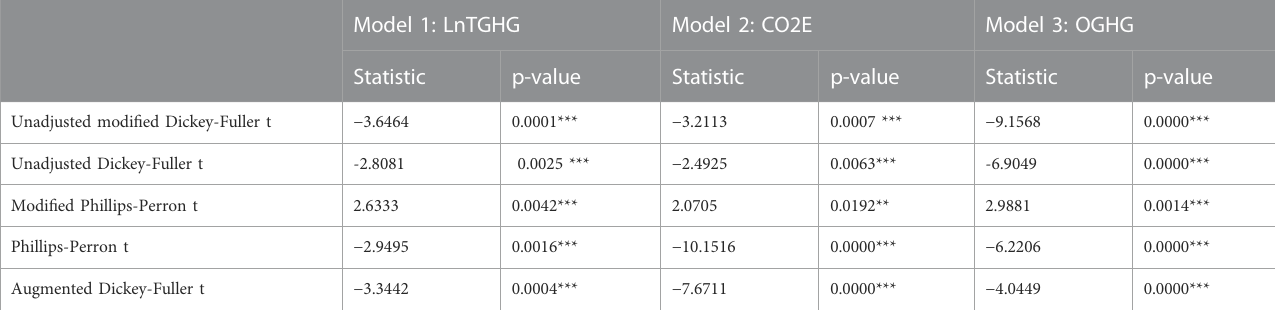
TABLE 7 Panel cointegration